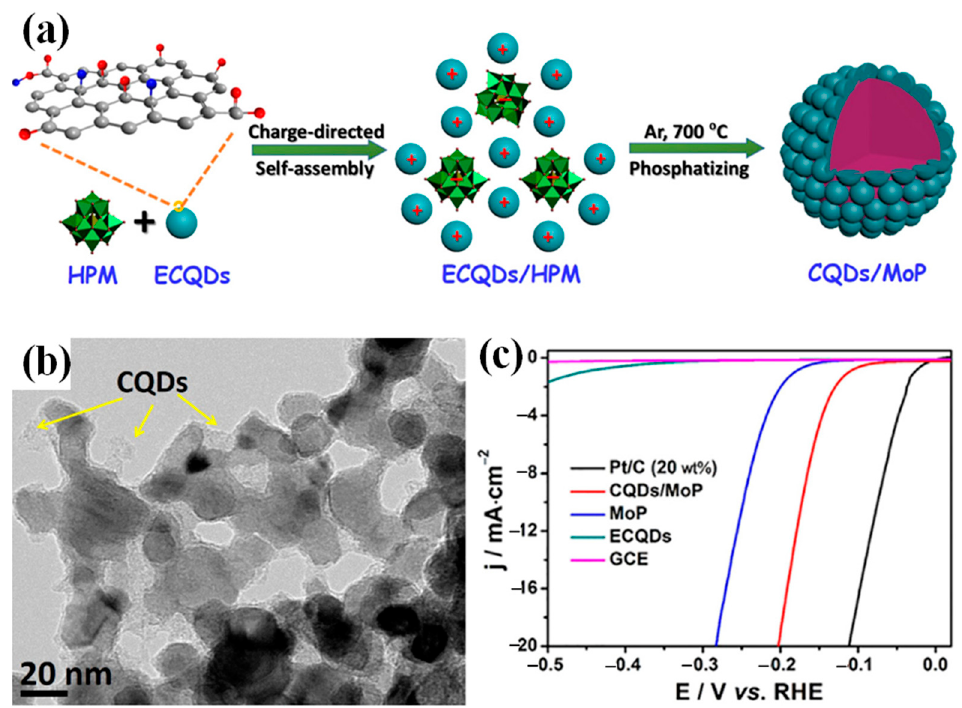
Figure 2. ( a ) Schematic illustration of CQDs/MoP synthesis. ( b ) TEM images of CQDs/MoP. ( c ) Polarization curves in 1 M KOH electrolyte. Reproduced with permission from [79]. Copyright 2018, American Chemical Society.